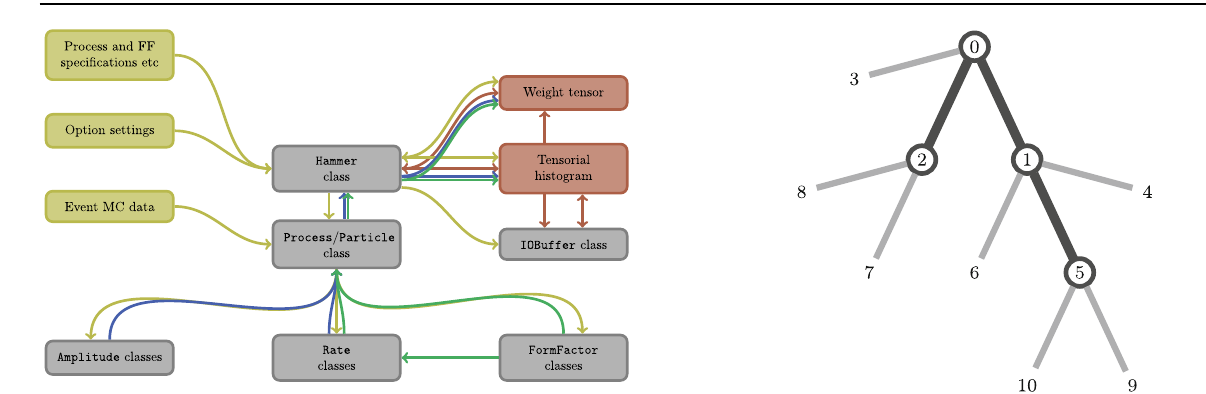
Fig. 6 Example process tree for a decay cascade involving 10 particles (numbers), 4 vertices (circles) and 3 edges (dark